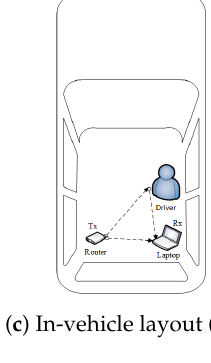
Figure 16. Varying